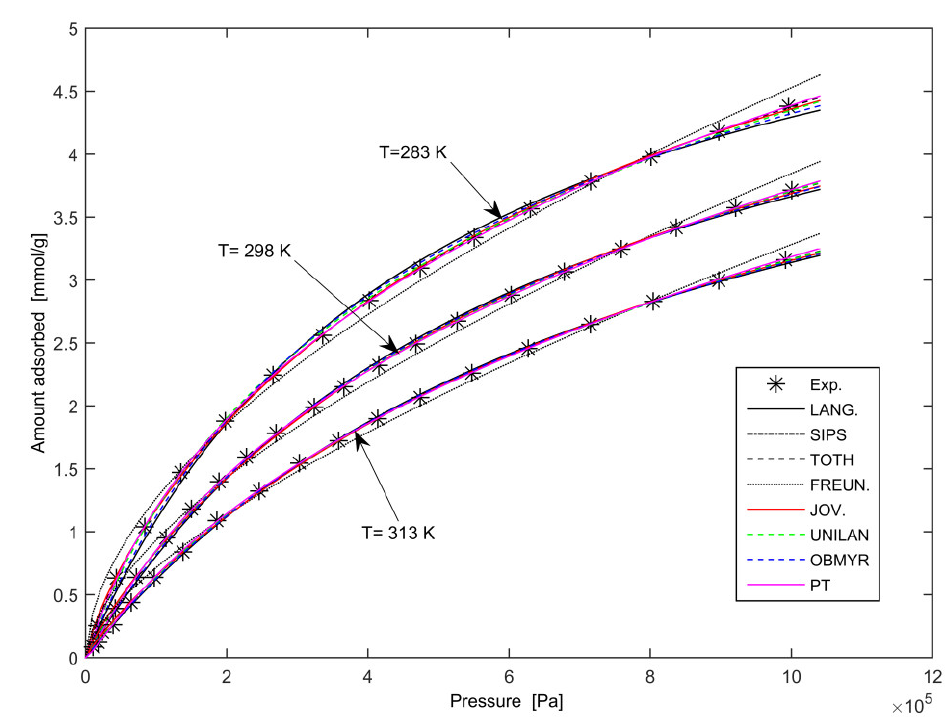
Figure 3. Pure-methane adsorption results on activated carbon JX101 .